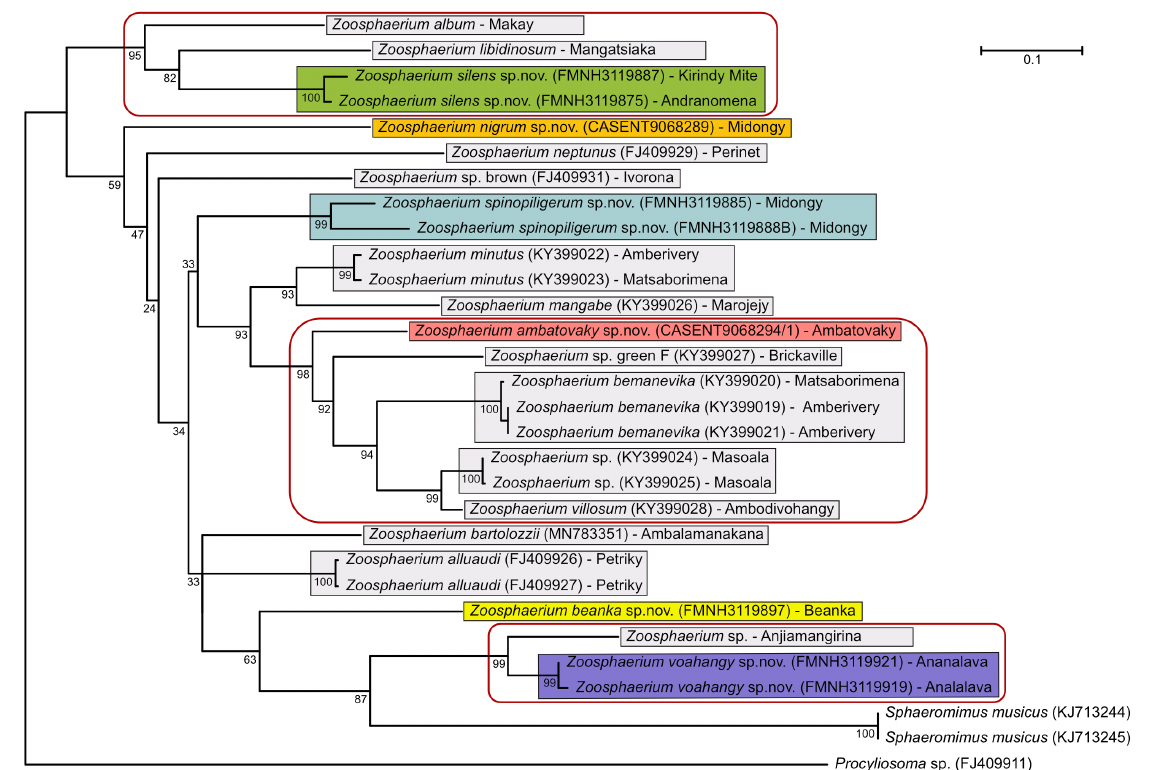
Fig. 1. Maximum likelihood tree inferred from the COI dataset with 1000 bootstrap pseudoreplicates implementing the GTR + I + G model. Colors representing newly described species of Zoosphaerium : orange = Z. nigrum sp. nov.; green = Z. silens sp. nov.; red = Z. ambatovaky sp. nov.; yellow = Z. beanka sp. nov.; purple = Z. voahangy sp. nov.; blue = Z. masoala sp. nov. Round-cornered rectangles indicate well-supported sister group